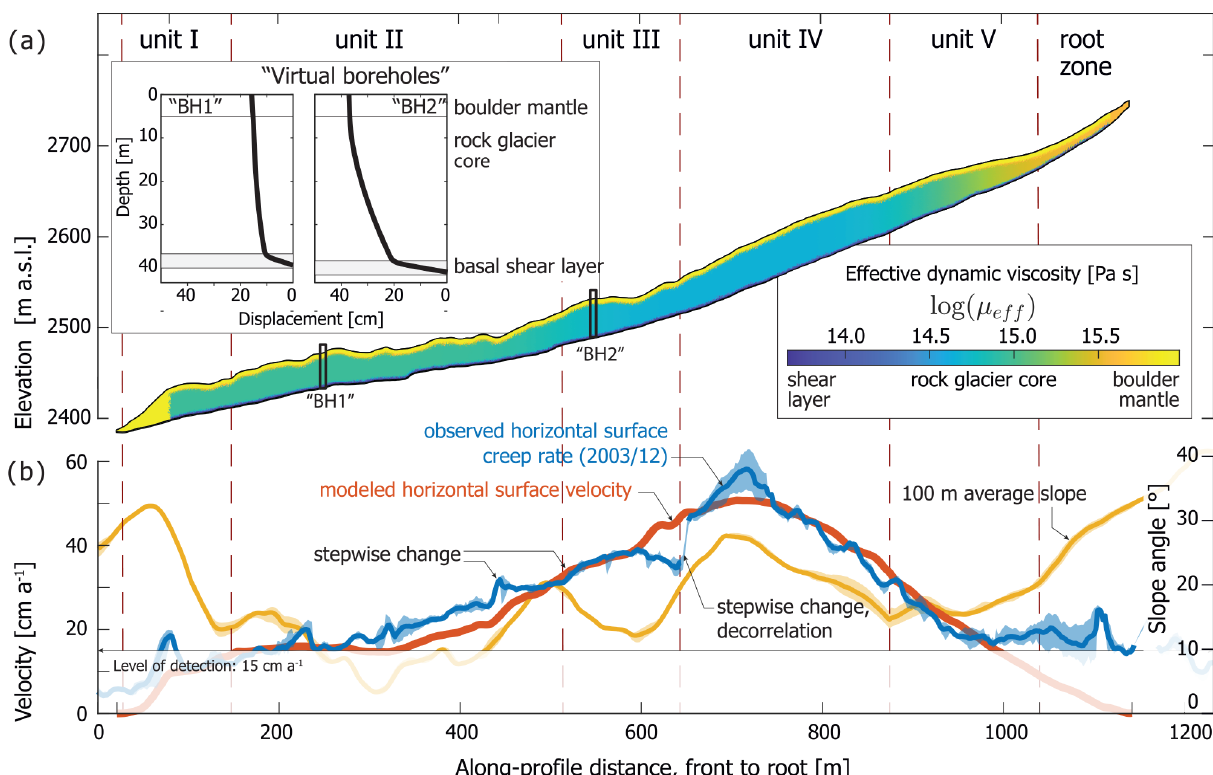
Figure 10. (a) Inferred effective viscosity distribution on the longitudinal transect (profile line shown in Figs. 4, 8). The inferred effective dynamic viscosity does not vary significantly over units II–IV. Along-profile variations in surface creep rates are primarily controlled by the surface slope. Insets: modeled yearly horizontal displacements in “virtual boreholes”. The strain localization near the base despite the linear stress–strain rate relationship arises from the rock glacier parameterization with the three-part mechanical layering (boulder mantle, core, basal shear layer). The simple Newtonian model with depth-varying viscosity generates synthetic velocity profiles that resemble borehole deformations measured on other rock glaciers. (b) Longitudinal section of observed surface creep rate (blue line), modeled or synthetic horizontal surface velocity (orange), and the 100m filtered slope (yellow). Horizontal surface creep rate of sections dominated by viscous creep roughly follow the average surface slope (units II–IV). Correlation is lost on the lowermost front and talus. The morphologically defined units I–II, unit III, and units IV–V are separated by sharp speed gradients (stepwise changes in surface creep rate, kinematic discontinuities; Fig.